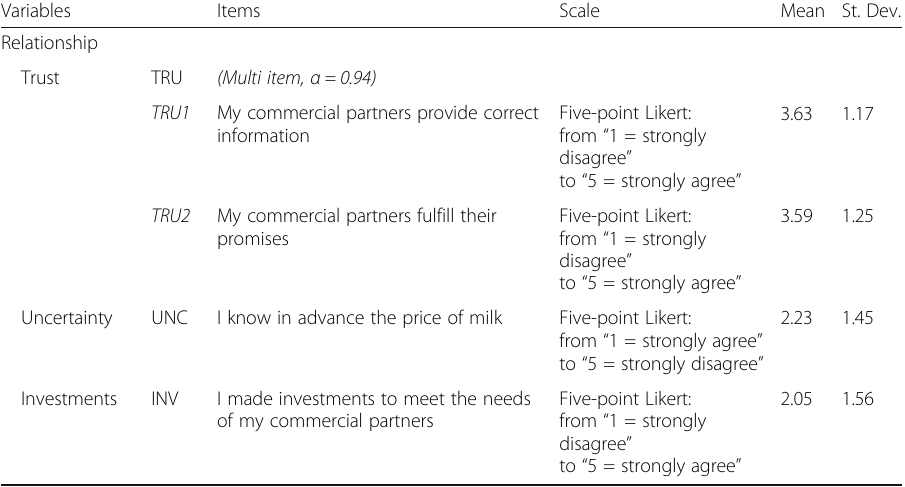
Table 4 Items and scales used in the questionnaire (Continued)